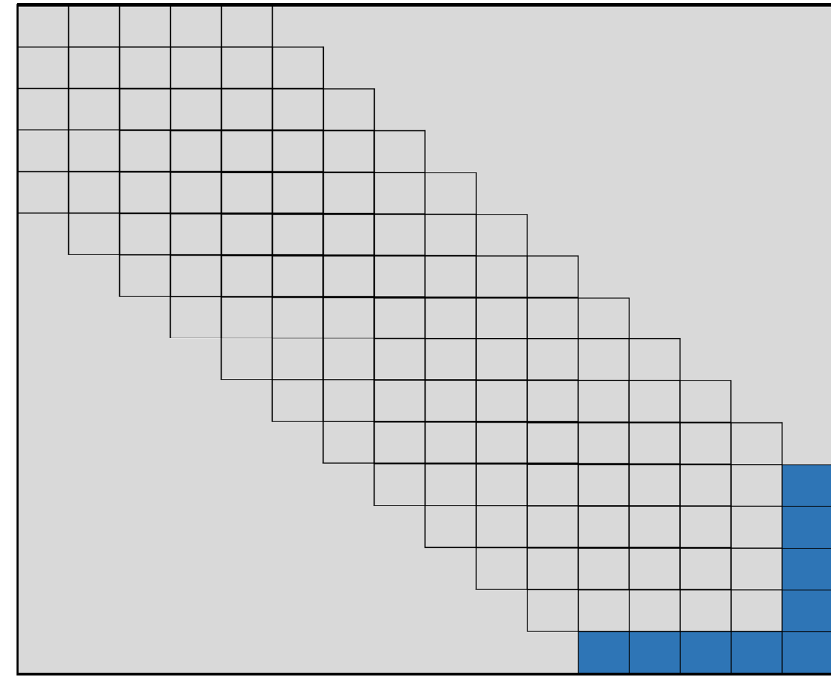
Figure 3. Stepwise SB interferograms temporal phase optimization.